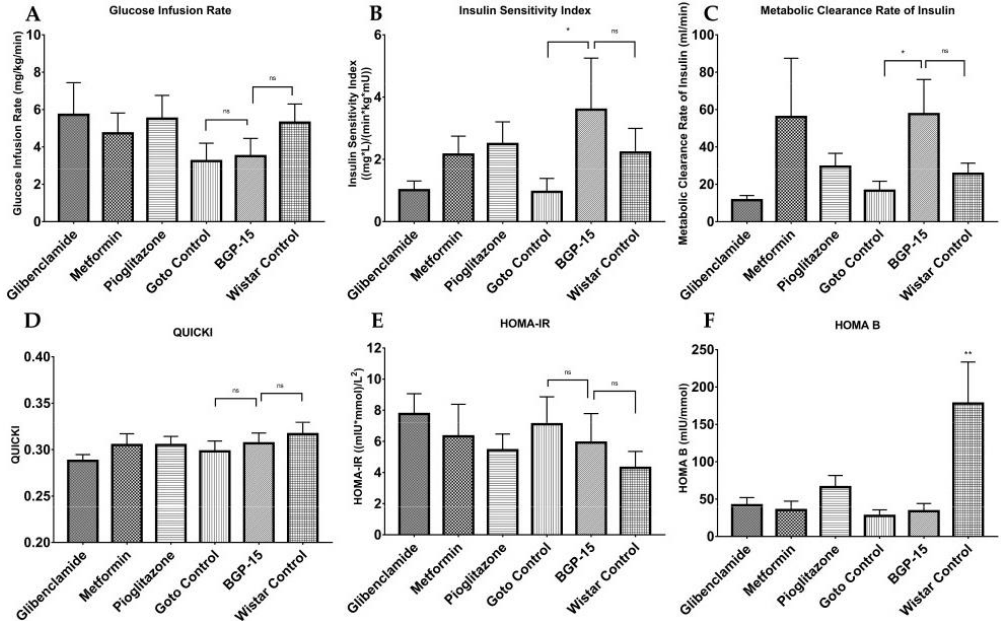
Figure 8. Additional calculated indices based on HEGC protocol. A : Glucose Infusion Rate; B : Insulin Sensitivity Index; C Metabolic Clearance Rate of Insulin; D : Quantitative insulin sensitivity